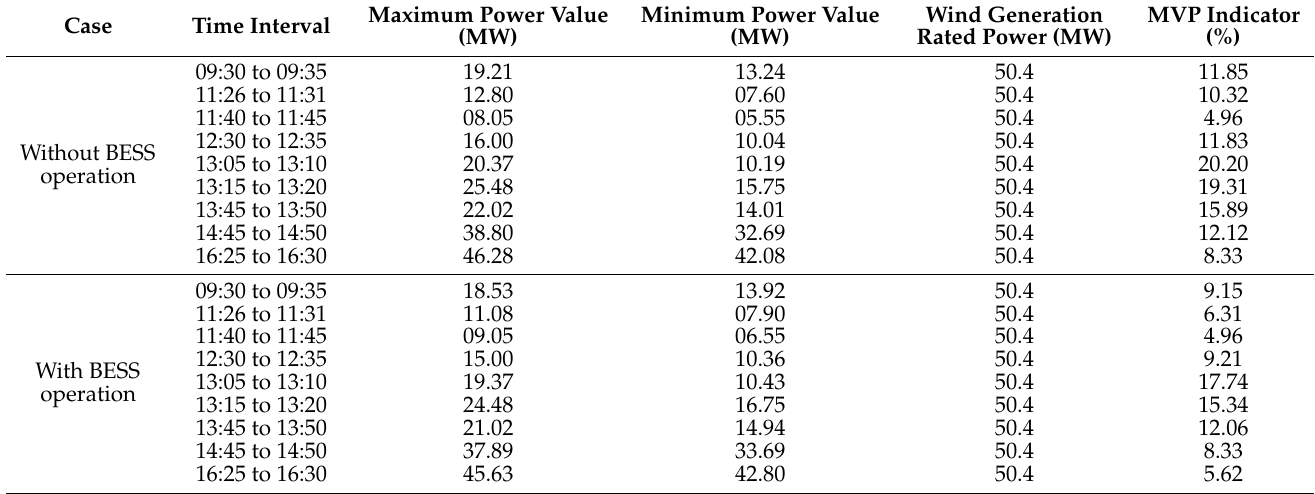
Table 3. Main indicators of power factor smoothing on 10/19/2021 .